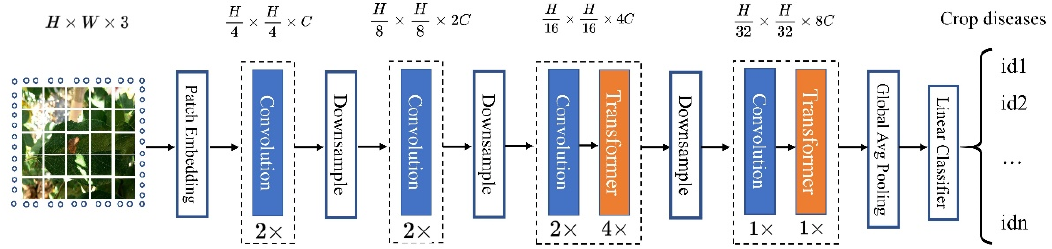
Figure 2. The overview of the model. The dots around the input image that is split into patches are filled with 0. Patch Embedding is the spreading of the input image patch into a one-dimensional vector as the input of Transformer structure, Convolution stands for convolution structure, Downsample stands for downsampling, which consists of convolution, and Transformer stands for Transformer structure.